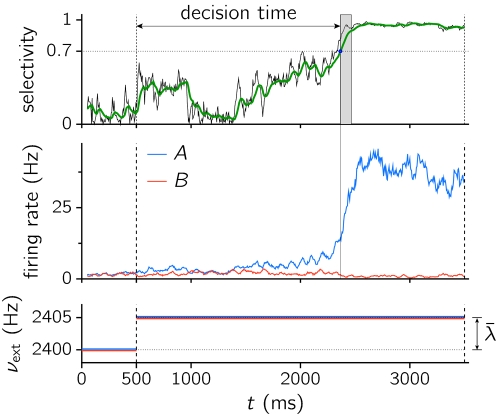
Evolution of the selectivity index (top), the average activity of populations A and B (middle), and stimulation applied (bottom), along a single trial.The green line in the top panel is the low-pass filtered selectivity with τ = 50 ms. From 0 to 500 ms no stimulation is applied (λ̅ = 0). From 500 ms to the end of the trial, λ̅ is set to a constant value different from zero (ν
ext = ν
0+λ̅ for selective cells). The decision time (DT) was the time elapsed between stimulus onset and the time at which the low-pass filtered selectivity index crossed the threshold 0.7 and stayed above it for at least 100 ms. The shaded area shows the time window within which the signal (green line) is required to be greater than the threshold. N = 2000, w
+ = 1.75, λ̅ = 5 Hz.